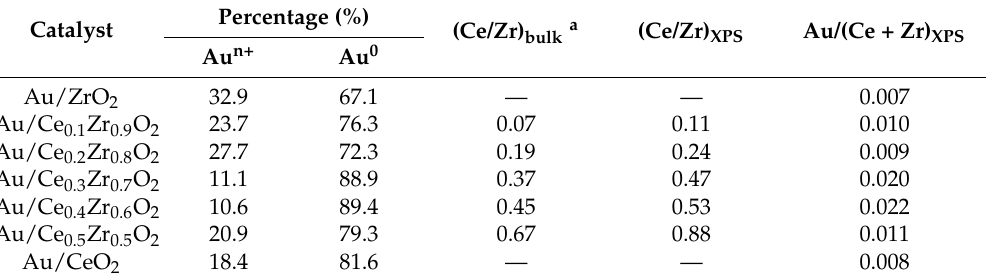
Table 1. XPS characterization of Au/Ce x Zr 1 − x O 2